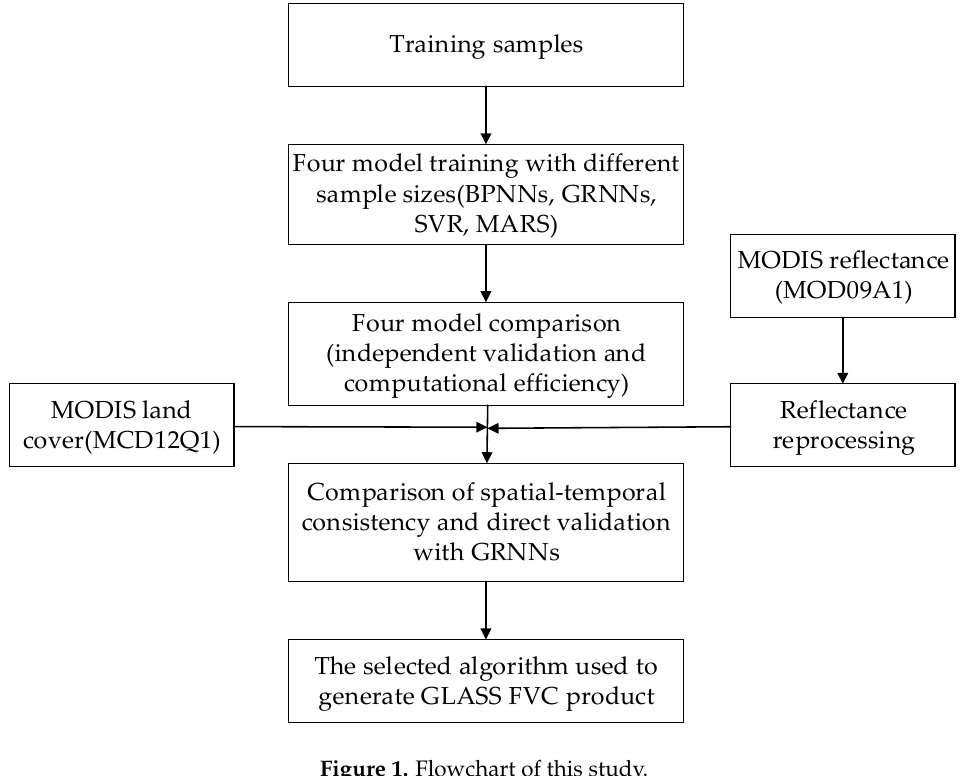
Figure 1. Flowchart of this study.